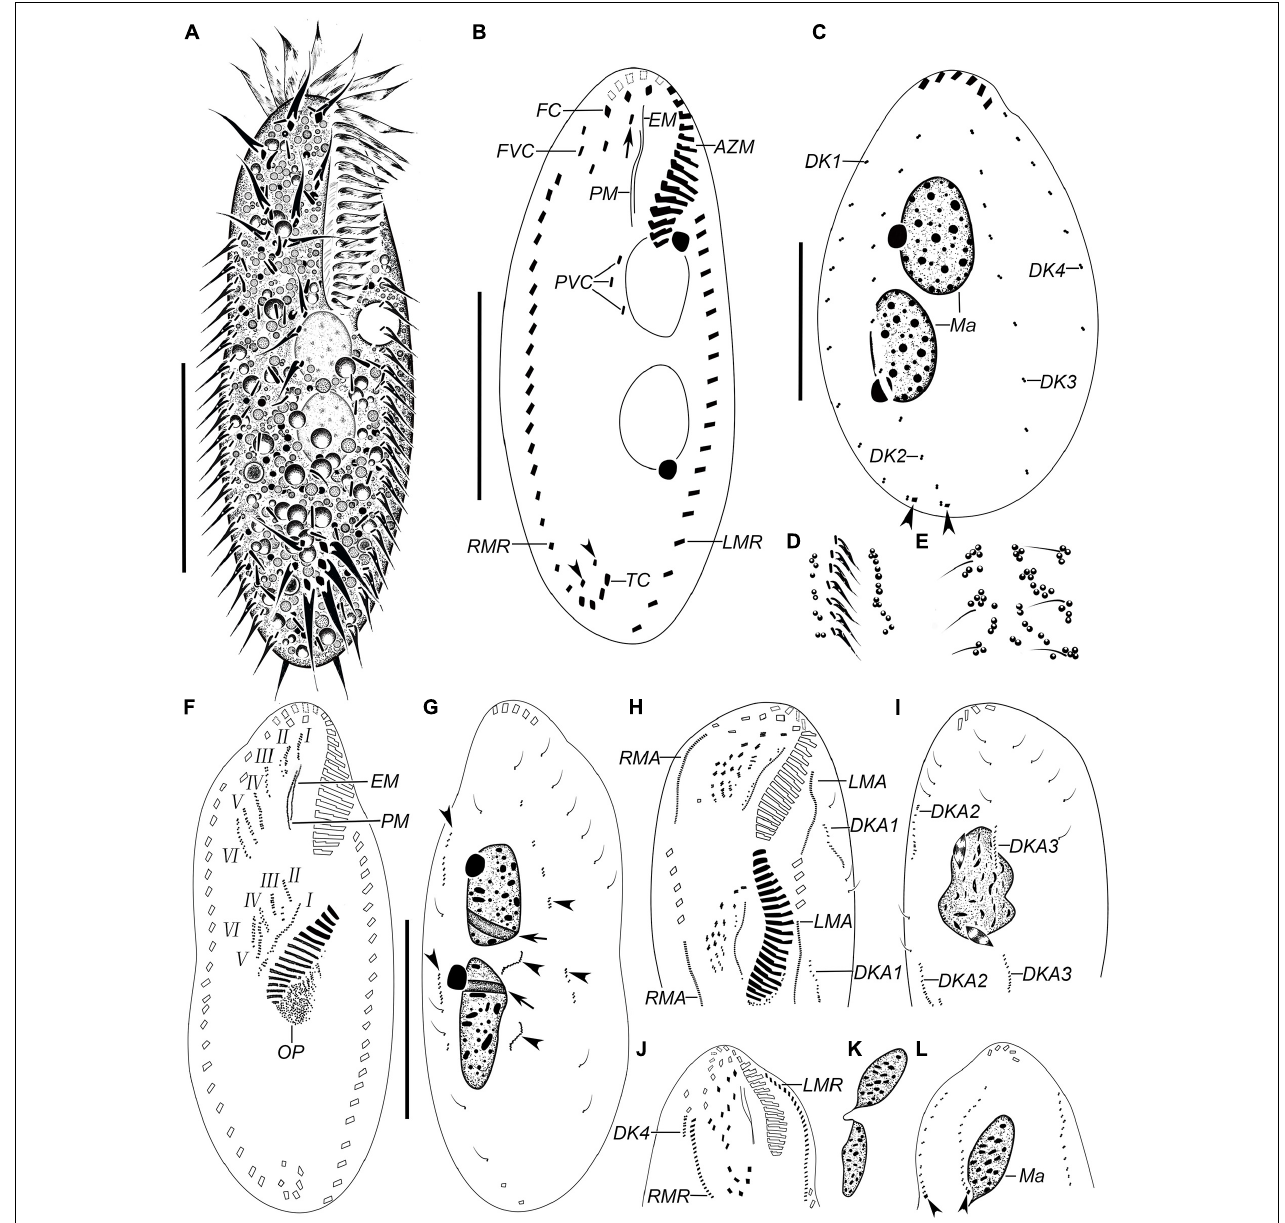
FIGURE 1 | Hemiurosomoida tibetensis sp. nov. in vivo (A,D,E) and after protargol staining (B,C,F–L) . (A) Ventral view of a representative individual. (B) Ventral view of the holotype, showing ciliature and nuclear apparatus, arrowheads in (B) indicate two pretransverse ventral cirri, arrow indicates buccal cirrus. (C) Dorsal kineties and nuclear apparatus, arrowheads mark caudal cirri. (D) Part of ventral view, to show the arrangement of cortical granules. (E) Part of dorsal view, to show the arrangement of cortical granules. (F,G) Ventral (F) and dorsal (G) view of the same early divider, showing the development of opisthe’s oral primordium and cirral anlagen; arrows indicate replication bands, arrowheads mark dorsal kineties anlagen. (H,I) Part of ventral (H) and dorsal (I) view of the same middle divider. Arrow in (H) and arrowhead in (I) mark buccal and paroral membrane, respectively. (J,L) Ventral (J) and dorsal (L) of the same proter at late morphogenesis stage, showing the ciliature, arrowheads indicate caudal cirri. (K) Two macronuclear nodules of the same proter as in figures (J,L) . AZM, adoral zone of membranelles; DK1–4, dorsal kineties 1–4; DKA1–3, dorsal kinety anlagen 1–3; EM, endoral membrane; FC, frontal cirri; FVC, frontoventral cirri; I–VI, frontal-ventral-transverse anlagen 1–VI; LMA, anlage of left marginal row; LMR, left marginal row; Ma, macronucleus; Mi, micronucleus; PM, paroral membrane; PVC postoral ventral cirri; RMA, anlage of right marginal row; RMR, right marginal row; TC, transverse cirri. Bars, 30 µ m.